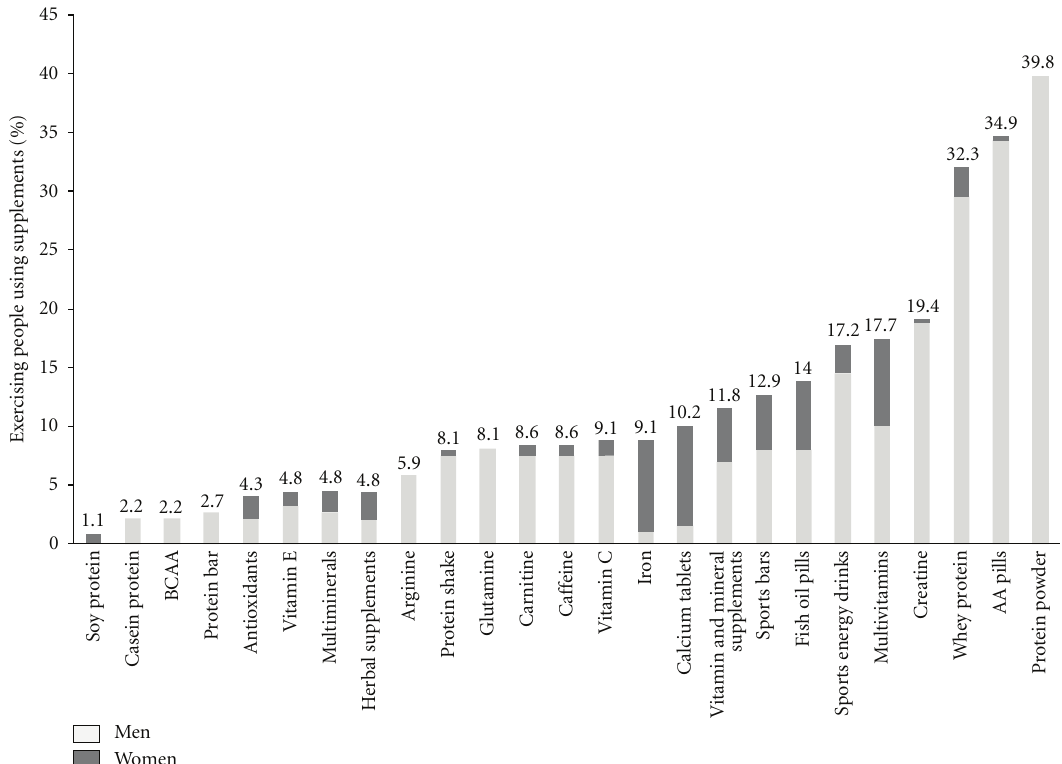
Figure 1: Types of nutritional supplements used among supplement users ( n = 186); BCAA: branched-chain amino acids; AA pills: amino acid pills. There are no missing